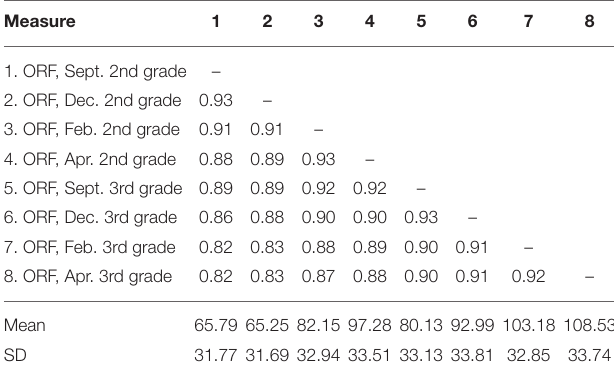
TABLE 2 | Correlations among waves of oral reading